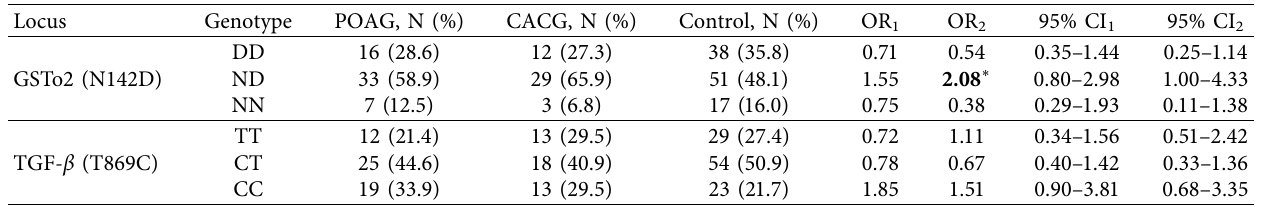
Table 3: The frequencies of GSTO2 (142N > D) and TGF- β 1 (869T > C) genotypes in POAG, CACG patients, and control groups.